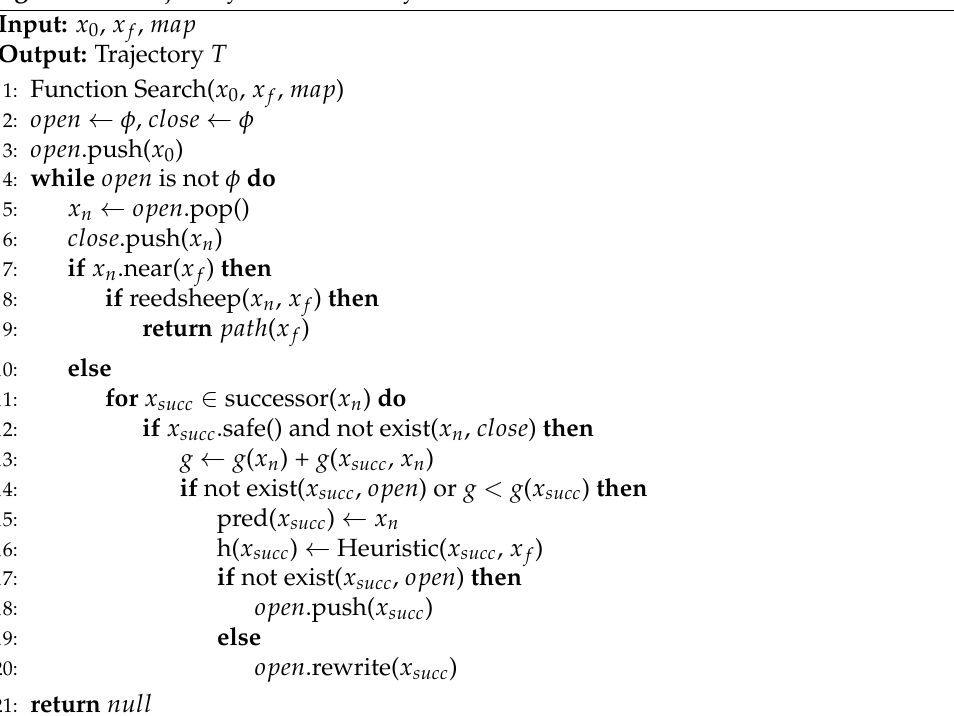
Algorithm 1 Trajectory Search with Hybrid